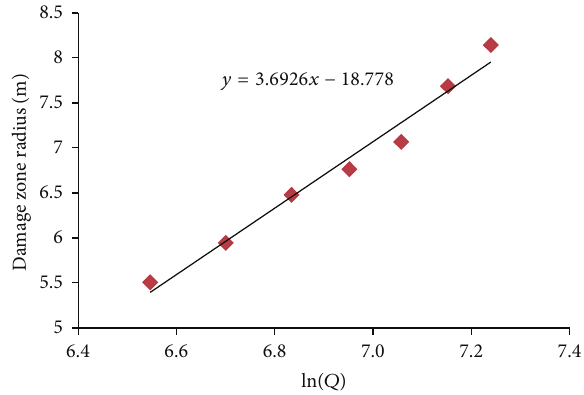
Figure 9: Fitting curve between damage zone radius and charge